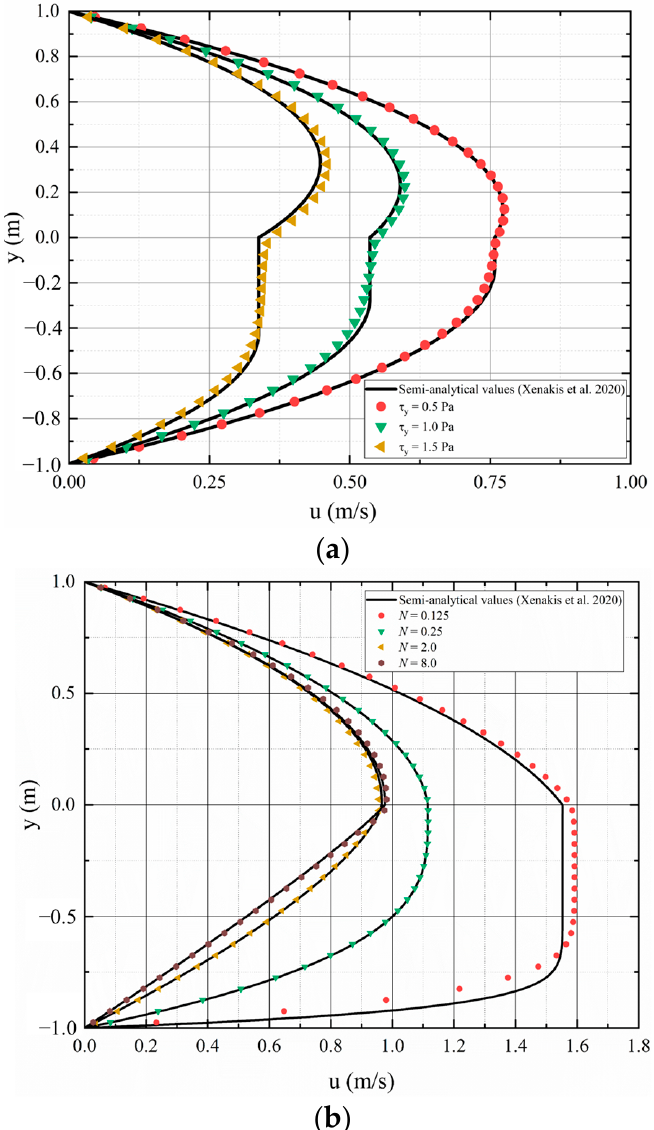
Figure 13. Velocity profiles of Newtonian and non-Newtonian interactions. ( a ) Bingham/Newtonian fluid interactions; ( b ) power law/Newtonian interactions.